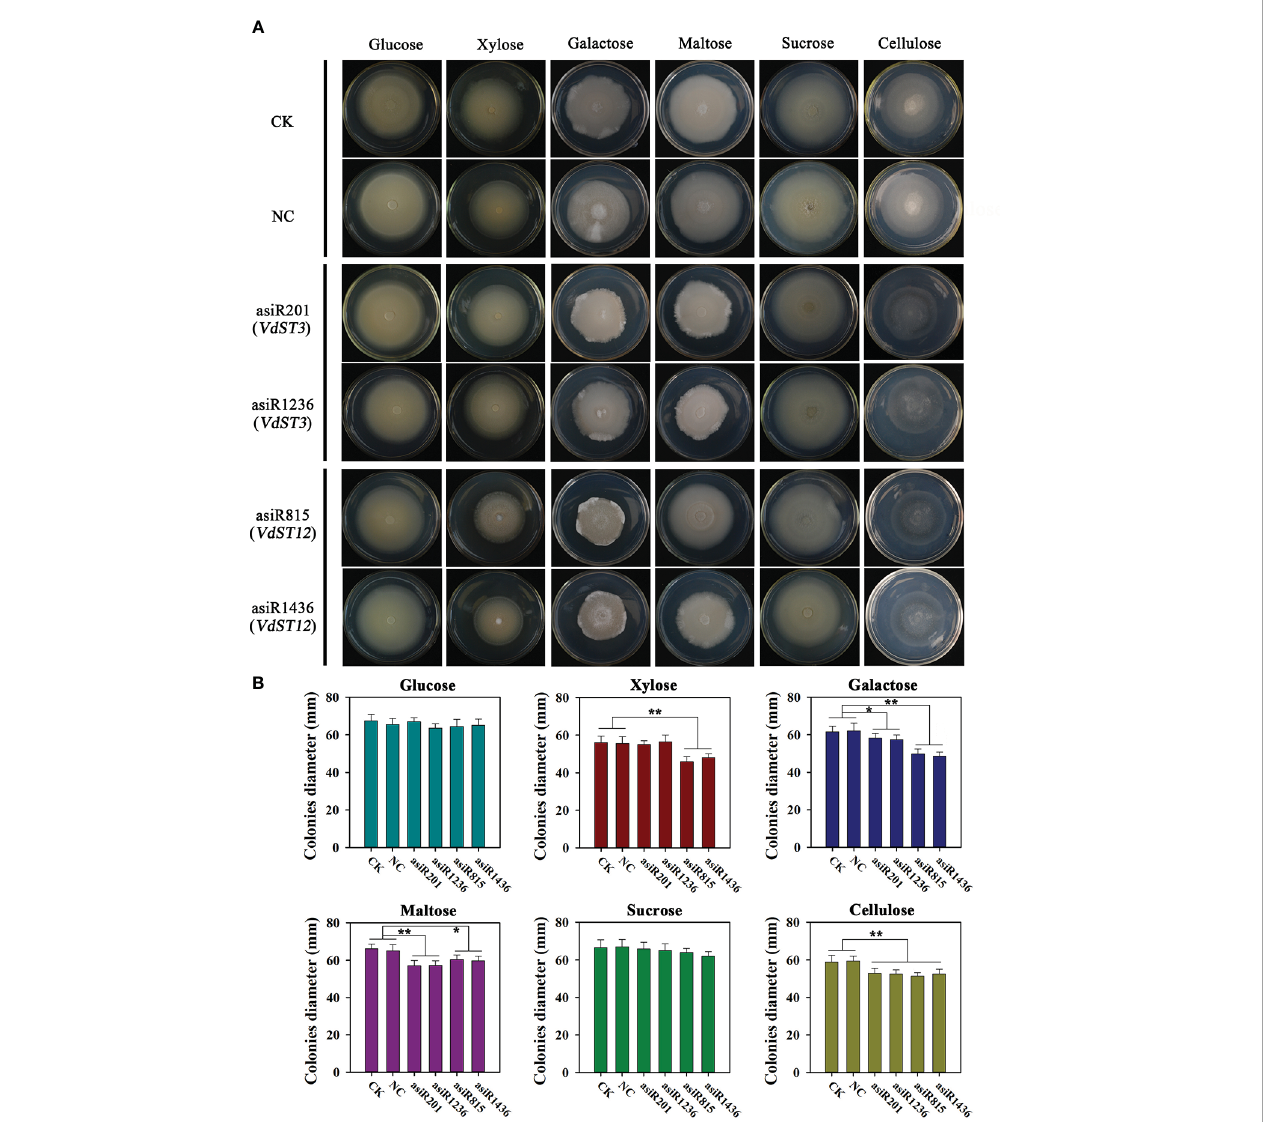
FIGURE 6 Morphology and diameter of colony from asiRNAs-treated strain on Czapek Dox medium with different carbon sources. (A) Colony morphology on Czapek Dox medium with different carbon sources. The Vd991 was co-cultured with asiRNA (200 nM) before inoculating on Czapek Dox medium. Wild- type Vd991 was used as control (CK), and Vd991 co-cultured with nematode asiRNA was used as negative control (NC). The images were taken at 15 days post incubation on PDA medium. (B) Colony diameter on Czapek Dox medium with different carbon sources. Values were means ± SD from three replicates. The above results were obtained in at least three independent experiments. The data were statistically analyzed by the IBM SPSS statistics 26.0. Statistical signi fi cance was determined using Student ’ s t-test. Asterisks (* and **) above the error bars indicated signi fi cant difference at p < 0.05 and p < 0.01 between asiRNA-treated strain and CK and